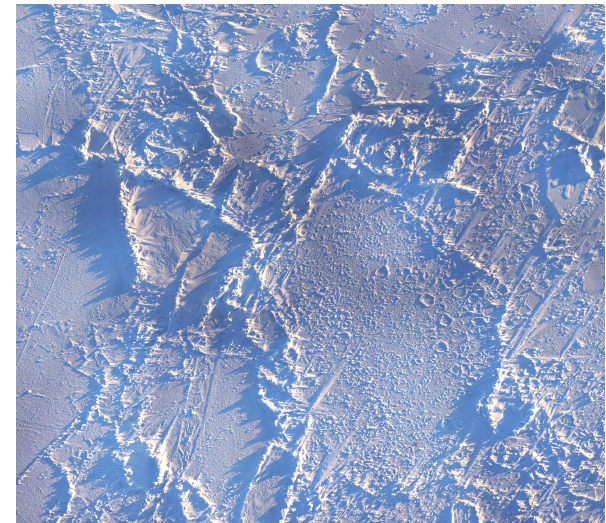
Figure 2. Drone imagery (180m × 180m) of heavily deformed ice in the Ross Sea, Antarctica. There are multiple ridges, which cannot be easily separated. The ridge widths and slopes are varying and must be arbitrarily defined, leading to a variety of possible values. Image provided by Guy